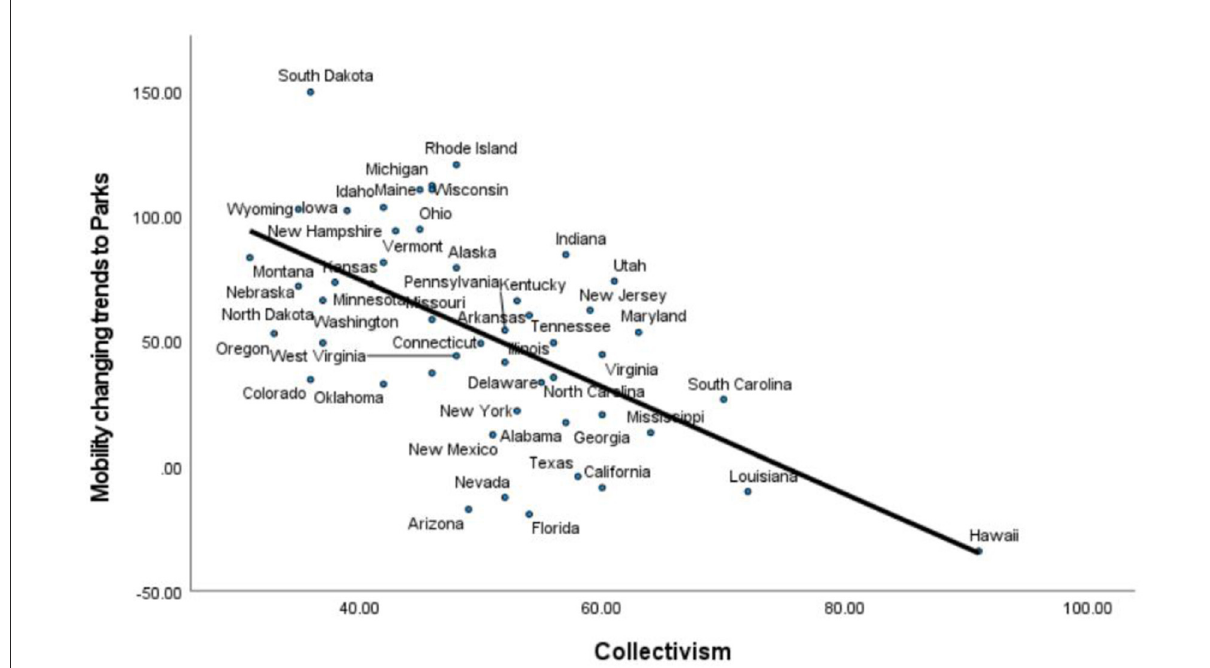
FIGURE1 Mobility trends to Parks reduced more in more collectivist US states. Mobility changing tends to Parks means the percentage of people’s visits to and length of stay at places of Parks that have changed compared with a baseline before the pandemic. Positive values denote increased visits whereas negative values denote decreased